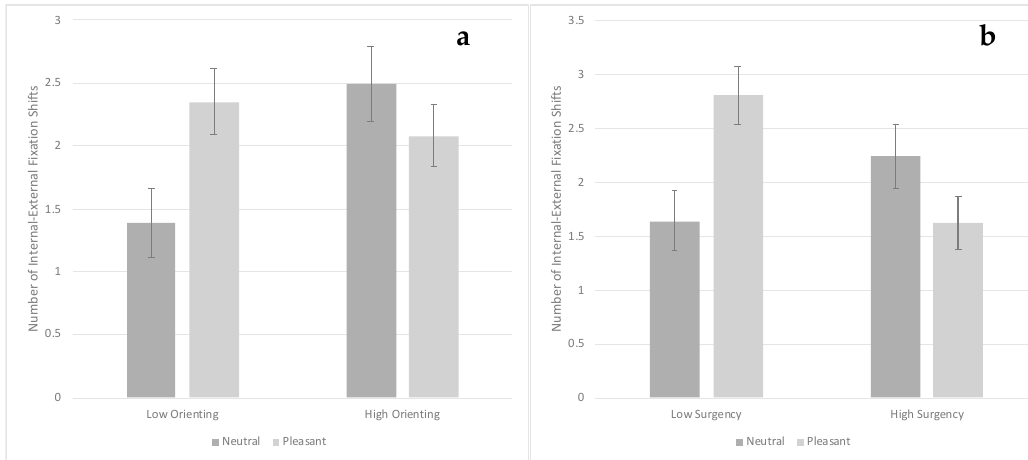
Figure 9. Number of fixation shifts between the internal and external features of the familiarized face based on facial expression and infants’ orienting (( a )—left chart) and based on facial expression and infants’ surgency (( b )—right chart). Bars represent standard error.